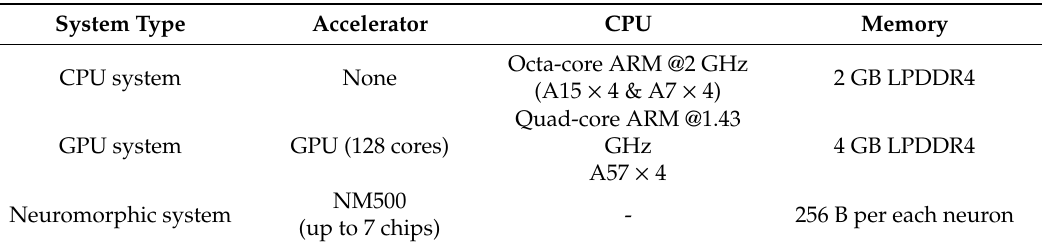
Table 2. Hardware specifications.